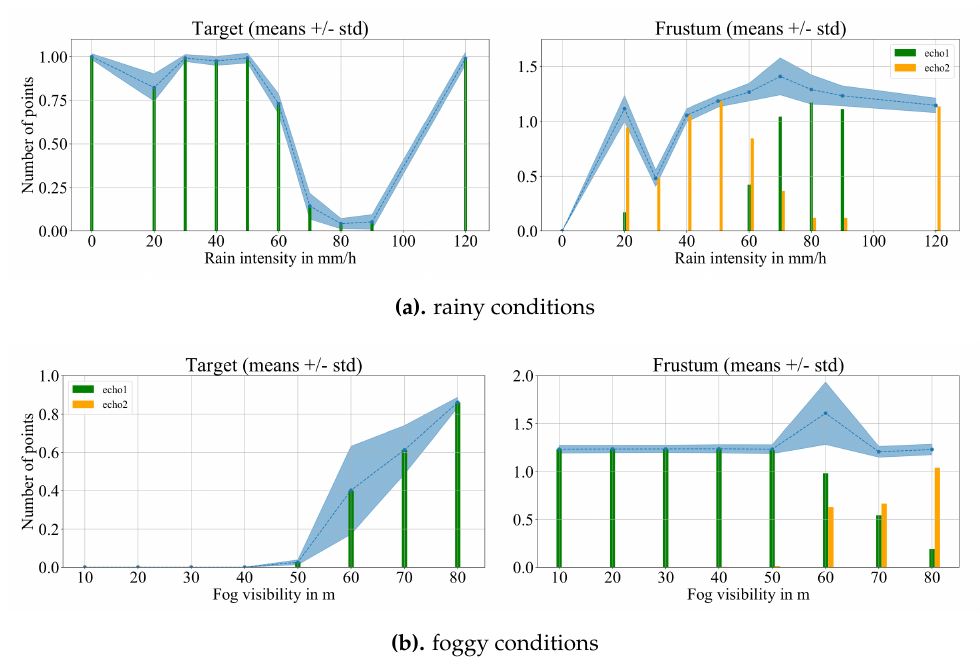
Figure 15. Results from VLP-32 with multi-echo